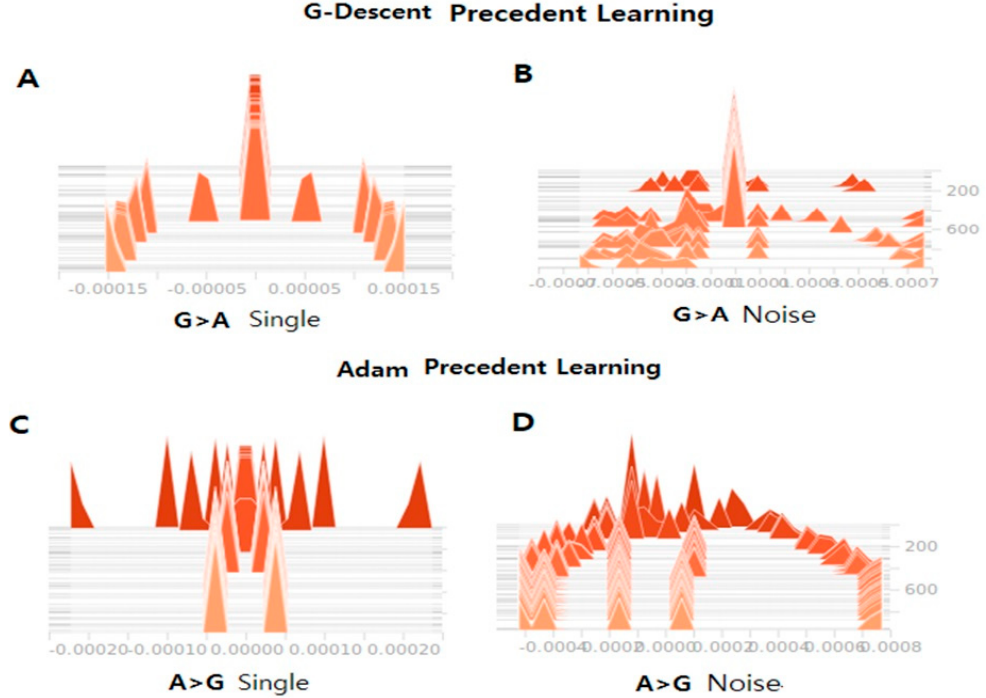
Figure 19. Visualization performance evaluation provided by TensorBoard: the vertical axis is the number of training, the horizontal axis is the number of weight; ( A ) and ( C ) is not include noise data, and ( B ) and ( D ) is include noise data; It is to see the result of how well the slope is distributed, and ( B ) and ( D) in the figure bring an even distribution that is not biased in one place as the learning